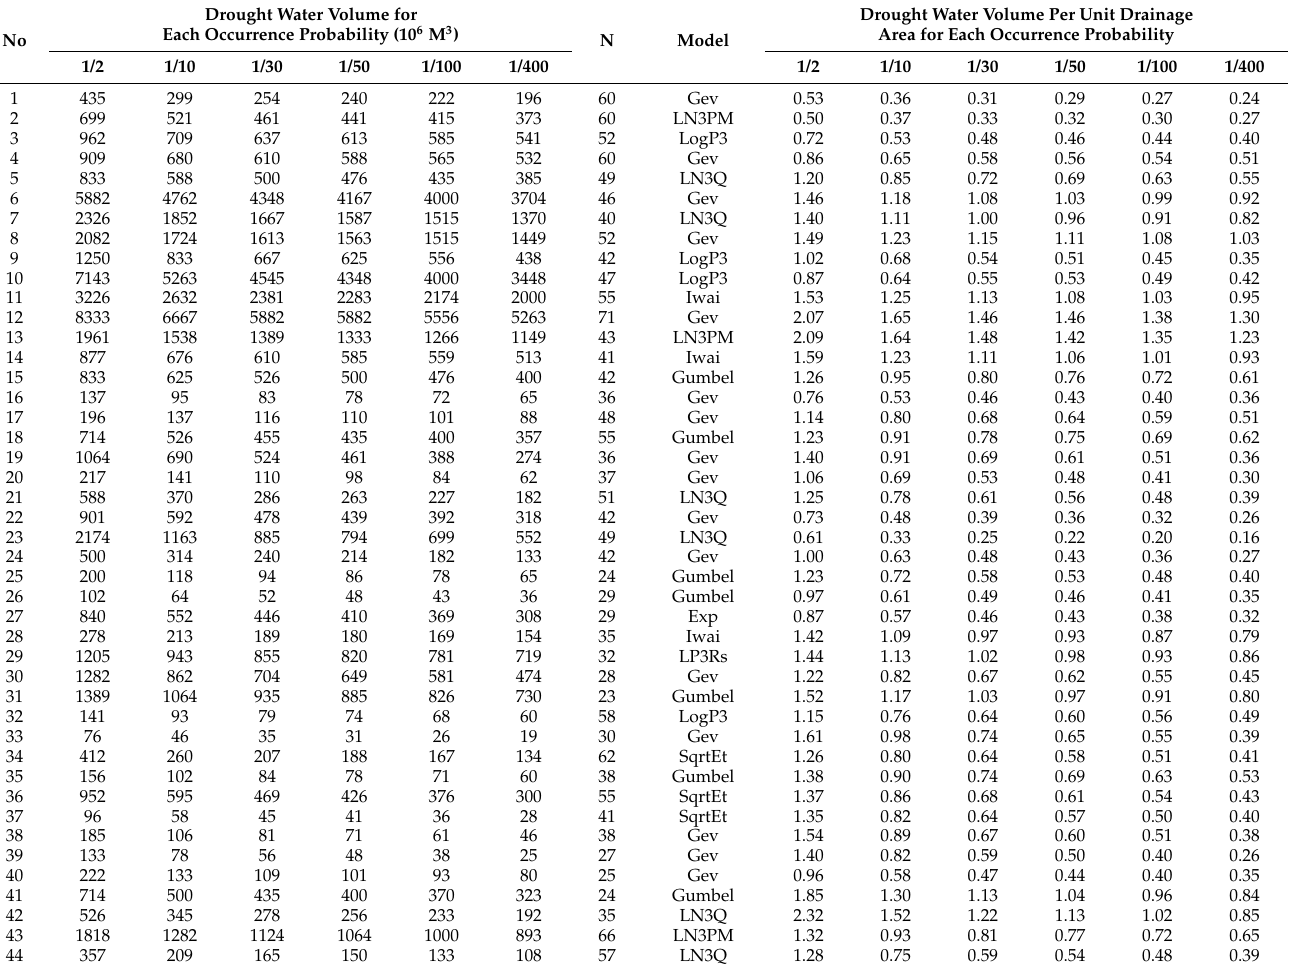
Table 2. The calculation result of drought runoff volume, and drought water volume per unit drainage area for each occurrence